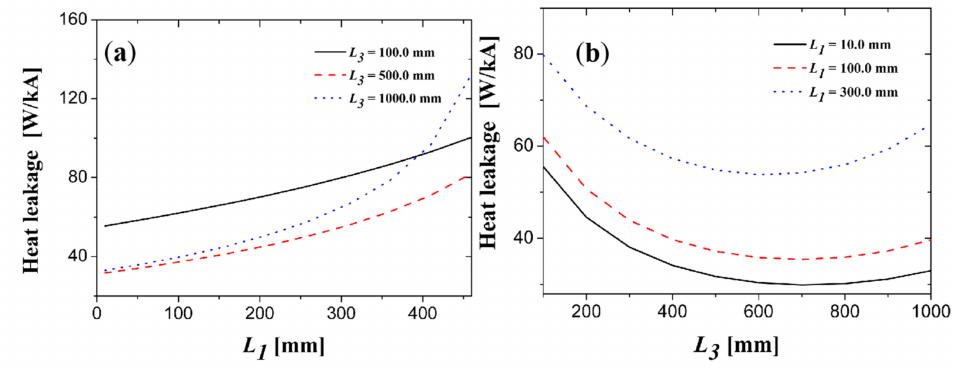
Figure A8. The coupling influence between B ( L 1 ) and C ( L 3 ) on the cold end heat leakage of PCLs. ( a ) The heat leakage vary with B ( L 1 ); ( b )The heat leakage vary with C ( L 3 ).